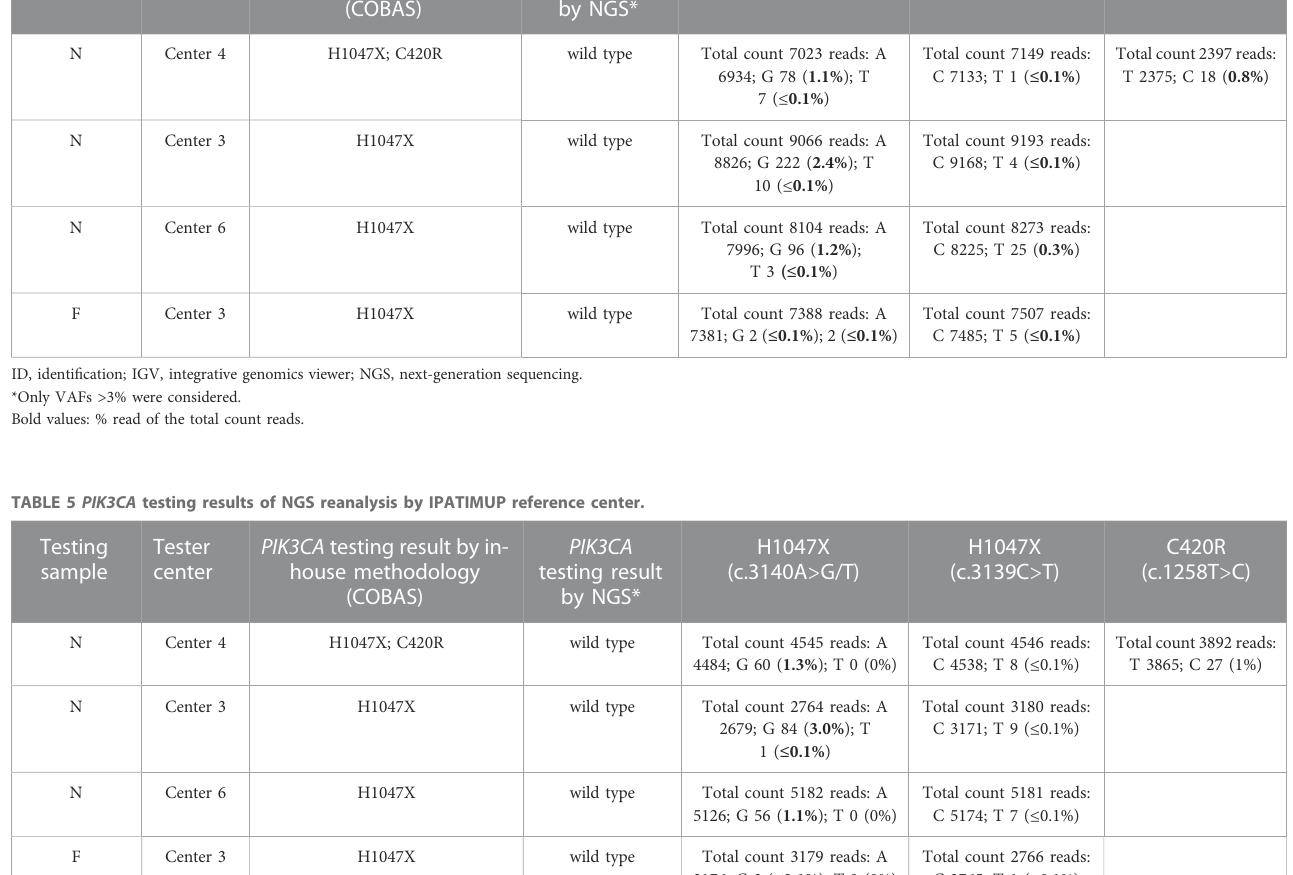
TABLE 4 PIK3CA testing results of NGS reanalysis by IPO-Porto reference center. Testing sample